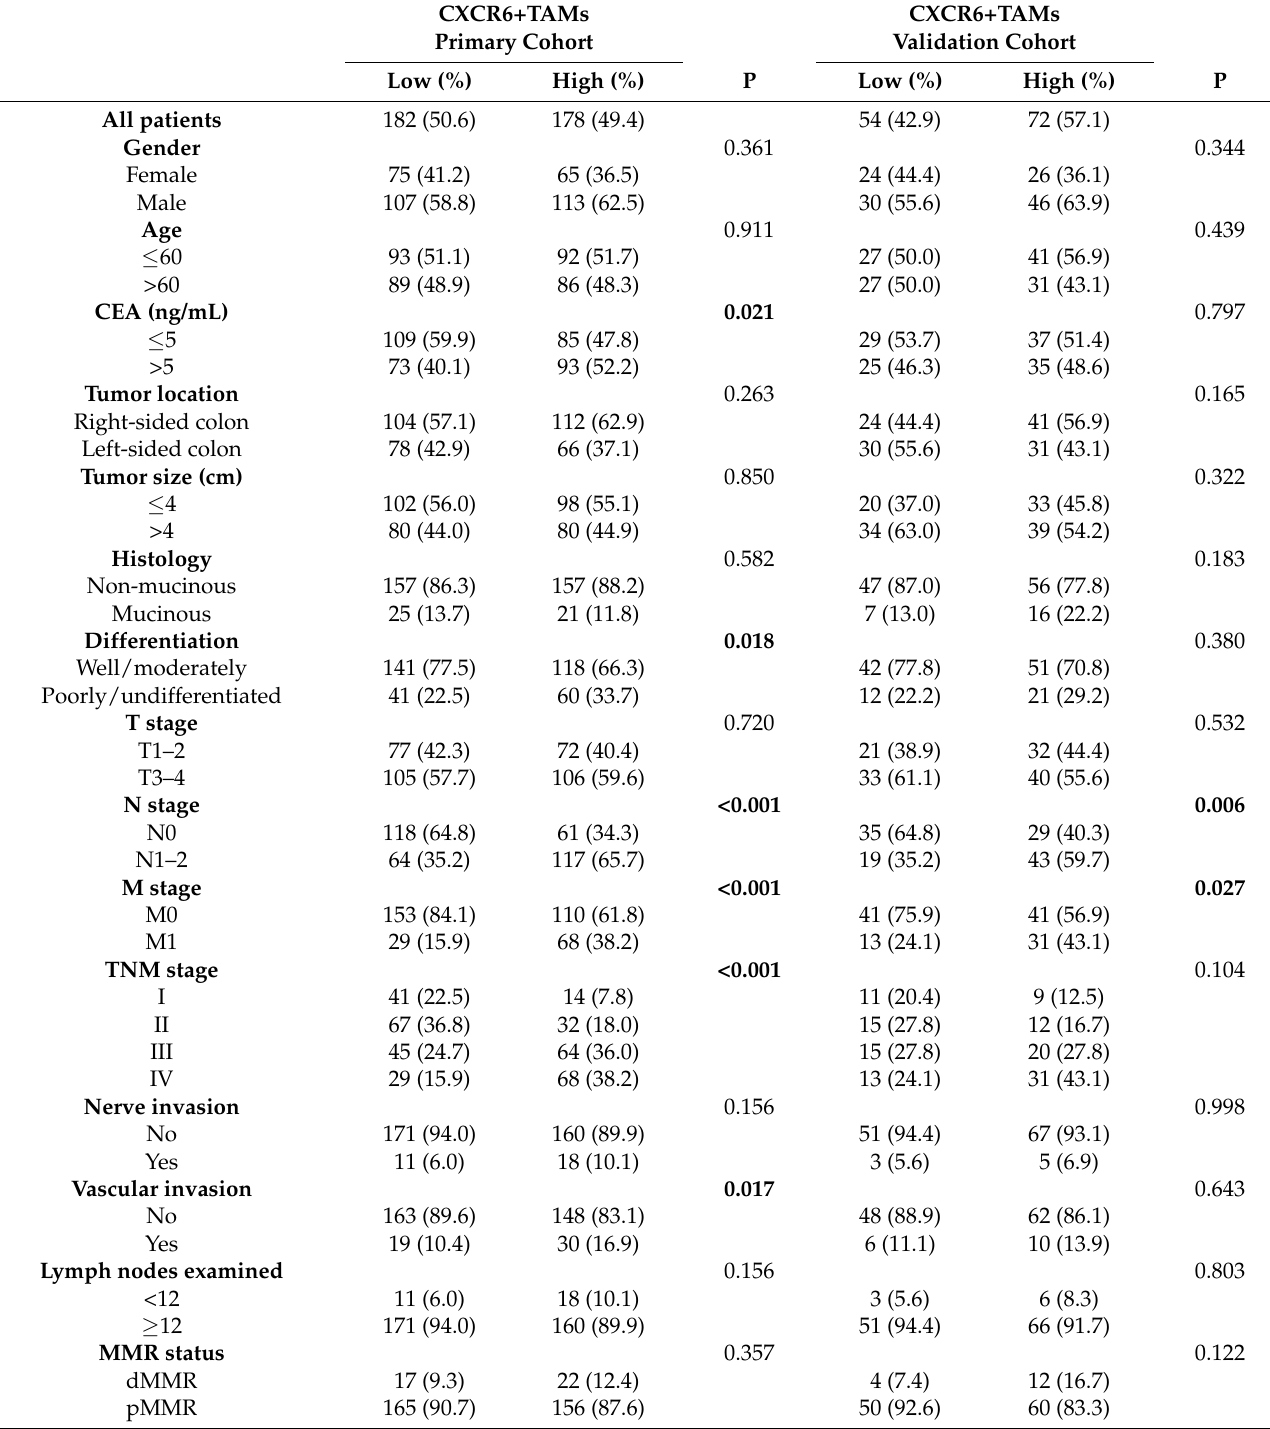
(Table 1); the median value (56 per mm 2 ) was chosen as the cut-off point for CXCR6+TAM high- and low-density groups. The expression of CXCR6+TAMs was higher in lymph node metastasis and distant metastasis groups. The baseline data are summarized in Table S1, and the infiltration of CXCR6+TAMs in peritumor tissue is shown in Figure S1. Table 1. Relationship between the number of CXCR6+TAMs and clinical